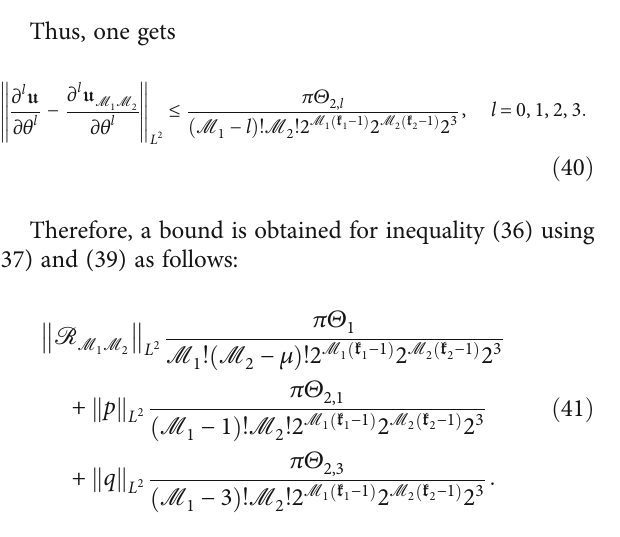
Figure 1: Exact and approximate solutions for k